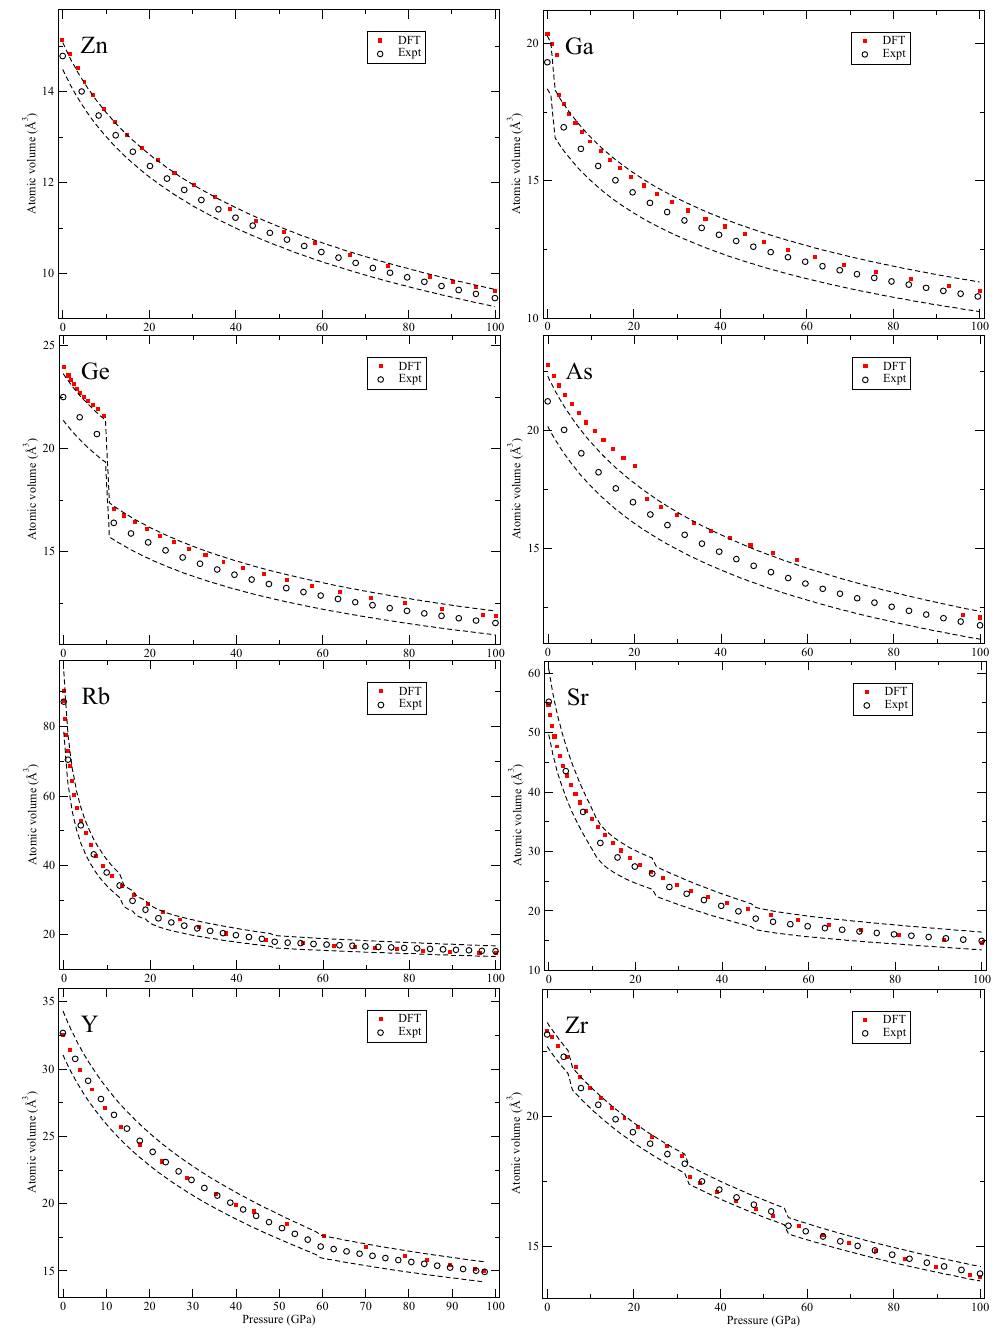
Figure 4. Experimental and DFT EOS for Zn, Ga, Ge, As, Rb, Sr, Y and Zr.